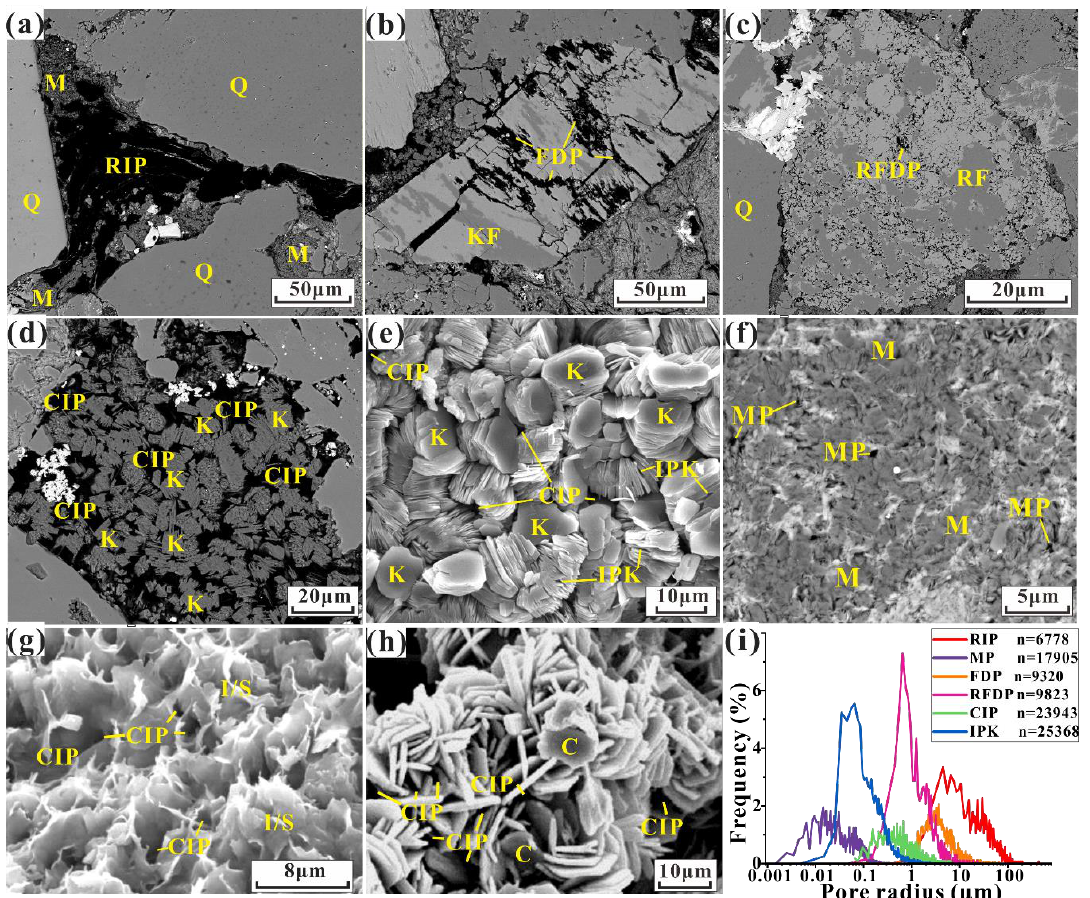
Figure 5. The geometries and sizes of the six types of pores in the J 1 b tight sandstone samples: ( a ) residual intergranular pores (RIPs) between grains, well X1, sample 1674.5; ( b ) feldspar dissolution pores (FDPs) developed in K-feldspar, well X1, sample 1674.5; ( c ) rock fragment dissolution pores (RFDPs), well X1, sample 1627.5; ( d ) clay mineral intergranular pores (CIPs) occurring in a RFDP, well X1, sample 1907; ( e ) intercrystalline pores and intergranular pores of kaolinite (IPKs), well X1, sample 1787.2; ( f ) matrix with widely developed and a large number of matrix pores (MPs), well X1, sample 1714.6; ( g ) honeycombed intergranular pores developed among the I/S mixed layers, well X1, sample 1827.5; ( h ) intergranular pores of rosette chlorites, well X1, sample 1713; and ( i ) frequency distributions of the pore sizes of the aforementioned six pore types.